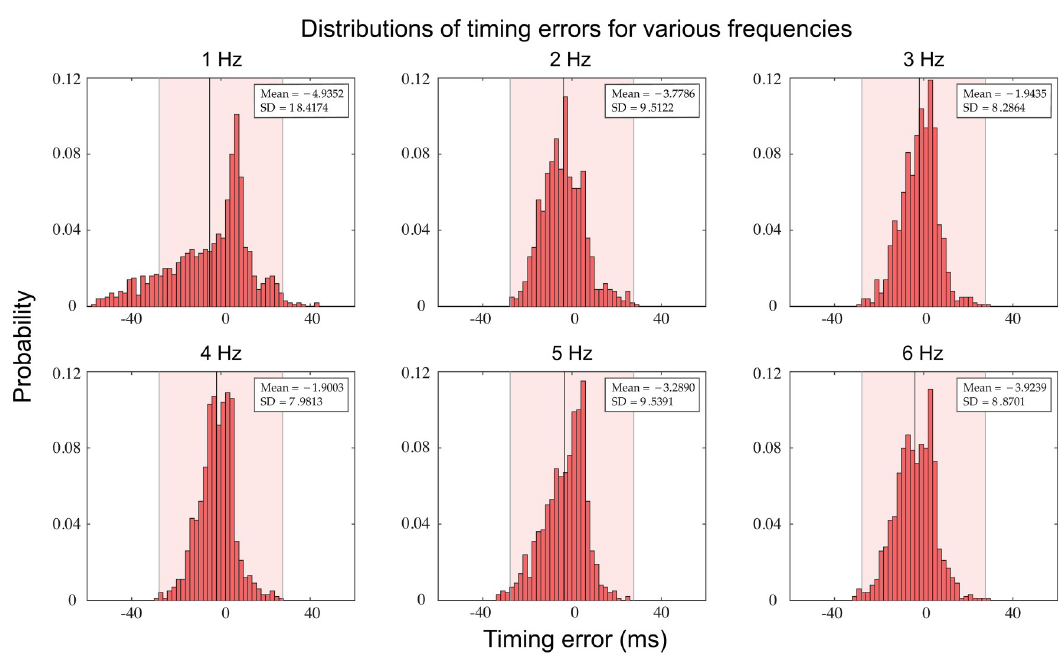
Fig 6. Timing error distributions of beat times. Histograms of timing errors (2 ms bins) based on simulations which ran for 1000 stimulus cycles during stationary behavior at six different stimulus frequencies. Negative mean asynchrony was seen in all cases (black vertical lines) and the standard deviation at the slowest frequency is largest. Pink shading represents a region of one gamma cycle accuracy.